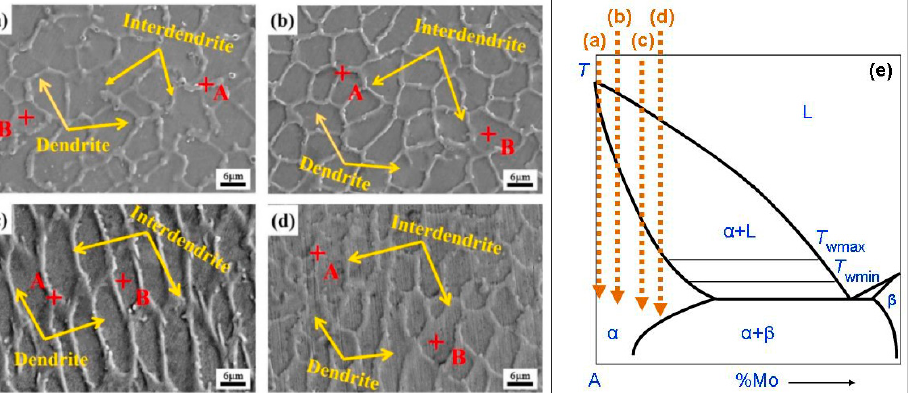
Figure 3. SEM micrographs of Mo0, Mo0.15, Mo0.20 and Mo0.25 HEA coatings ( a ) Mo0; ( b ) Mo0.15; ( c ) Mo0.20; ( d ) Mo0.25. The red points and letters A and B mark the locations of composition measurements. ( e ) Scheme with the binary phase diagram for the explanation of respective GB wetting processes. The dotted red arrows show the cooling trajectories corresponding to the micrographs ( a – d ). Micrographs ( a – d ) are reprinted with permission from Ref. [47]. Copyright 2021 Elsevier.